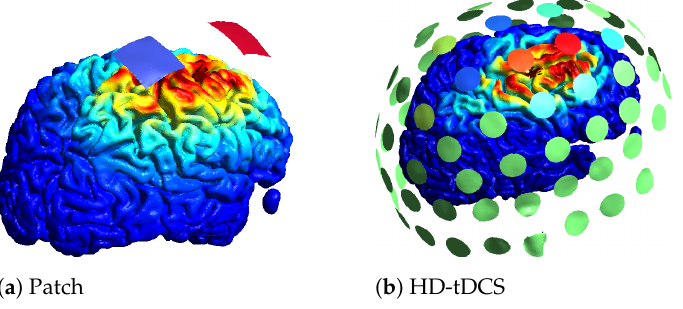
Figure 4. Different optimization results obtained using